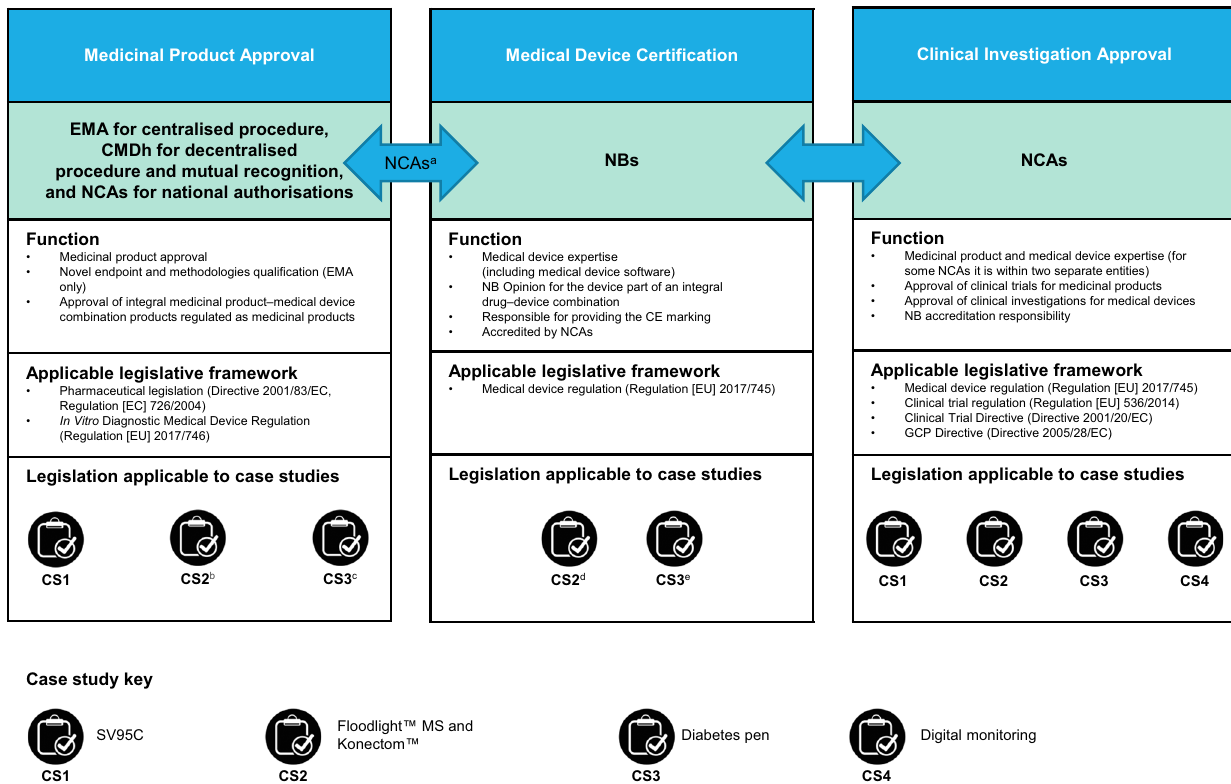
Fig. 1 Summary of regulatory bodies, their function, and the legislative framework relevant to digital health technology tools. Summary of the regulatory bodies responsible for medicinal product approval, medicine device certi fi cation and clinical investigation approval. Arrows represent formal interaction between regulatory bodies. Listed are the relevant legislative frameworks for each regulatory body and indicated below are the case studies where these frameworks are applicable. a For Article 117, interaction with NBs occurs via the manufacturer. b For the clinical trial tool. c For the injector pen. d For the SaMD functionality in clinical practice. e For the smartphone app. CE Conformitè Europëenne, CMDh Co-ordination Group for Mutual Recognition and Decentralised Procedures – human, CS case study, EC European Council, EMA European Medicines Agency, EU European Union, GCP Good Clinical Practice, MDSW medical device software, MS multiple sclerosis, NB Noti fi ed Body, NCA National Competent Authority, SV95C Stride Velocity 95th